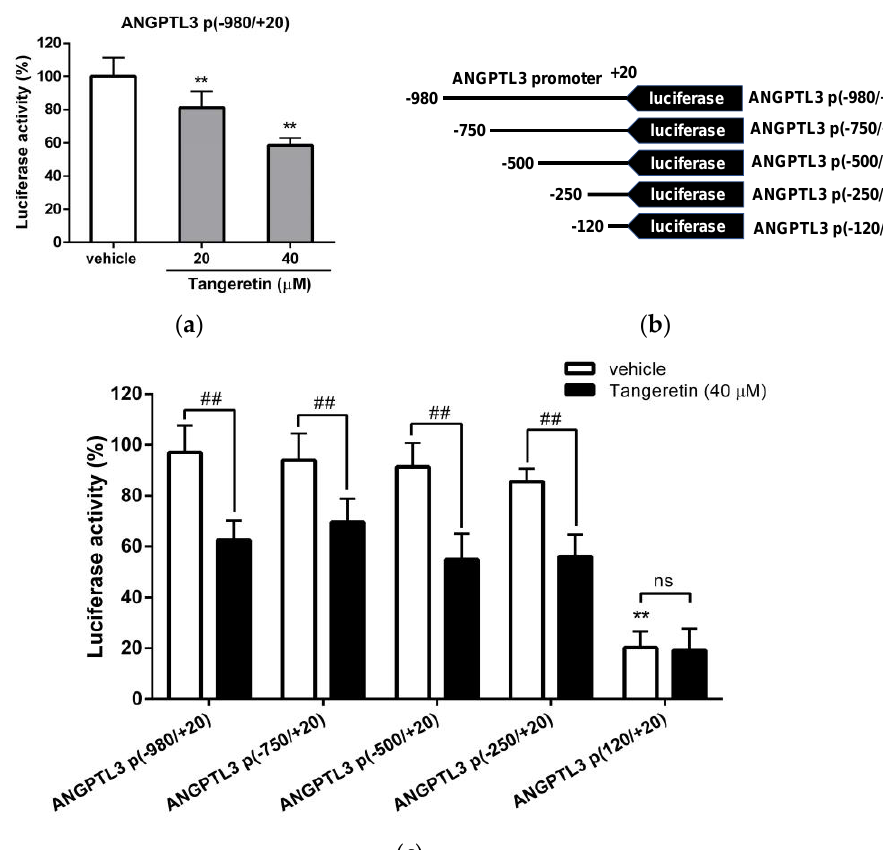
Figure 6. The effect of tangeretin on ANGPTL3 promoter activity. ( a ) HepG2 cells were cotransfected with an ANGPTL3 promoter–reporter plasmid (ANGPTL3 p( − 980/+20)) and a Renilla control plasmid for 24 h. The cells were then treated with vehicle (0.1% DMSO) or tangeretin (20 and 40 µ M) for 24 h. The luciferase activities were measured and normalized to their respective Renilla luciferase activities. The data represent the mean ± SD from three independent experiments. ** p < 0.01 indicates significant differences compared to the vehicle-treated cells. ( b ) Reporter plasmids containing serially deleted DNA fragments of the ANGPTL3 promoter. ( c ) HepG2 cells were cotransfected with serially deleted ANGPTL3 promoter–reporter plasmids and a Renilla plasmid for 24 h and then treated with vehicle or tangeretin (40 µ M) for an additional 24 h. The luciferase activities were measured and normalized to the respective Renilla luciferase activity. The data represent the mean ± SD of three independent experiments. ** p < 0.01 indicates a significant difference compared to vehicle-treated ANGPTL3 p( − 980/+20) plasmid-transfected cells. ## p < 0.01 indicates significant differences compared to the respective vehicle-treated cells. “ns” indicates no significance.